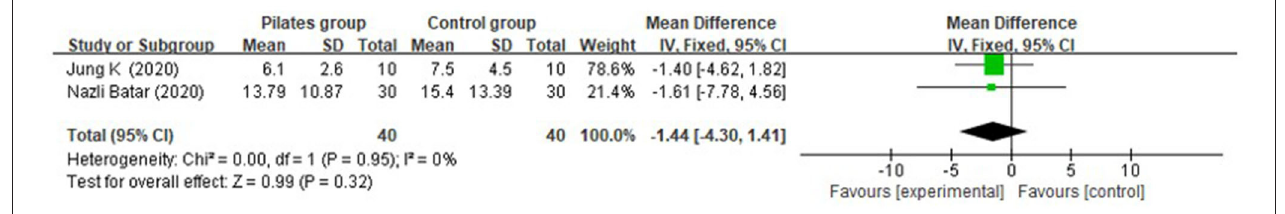
FIGURE 5 | Meta-analysis and forest plot for insulin.